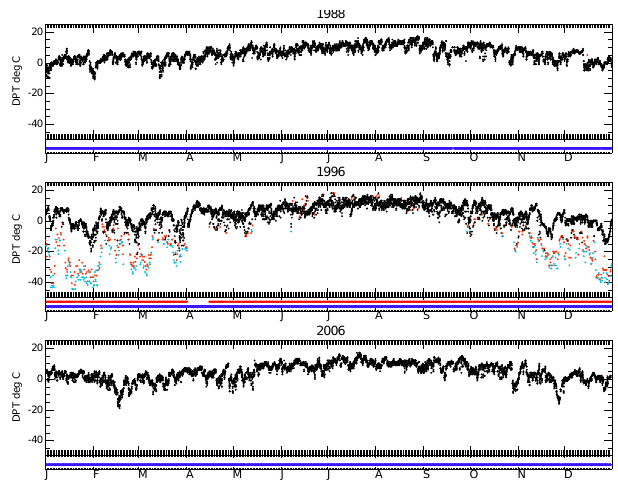
Fig. 12. Spike check (test 10) for composite station 718936-99999 (49.95 ◦ N, 125.267 ◦ W, 106m, Campbell River, BC, Canada), for dewpoint temperature showing the removal of a ghost station. Red points show values removed by this test and blue points by other tests. The panel below each year shows whether the data in the com- posited station come from the named station (blue) or a matched station (red). In 1988 and 2006 a single station is used for the data, but in 1996 there is clearly a blend between two stations (718936- 99999 and 712050-99999). In this case the compositing has caused the ghosting; however, both these stations are labelled in the ISD history file as Campbell River, with identical latitudes and longi- tudes. An earlier period of merger between these two stations did not lead to any ghosting effects.